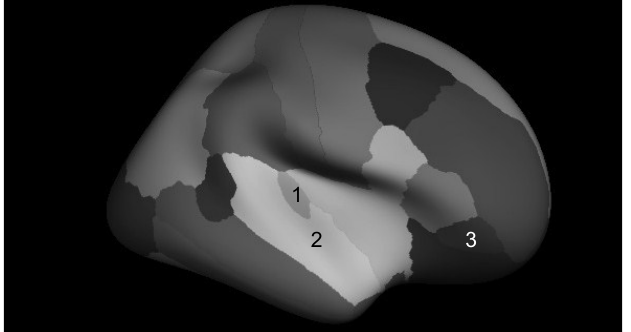
Figure 1. Cortical parcellation of the target regions of interest. ( 1 ) Transverse temporal gyrus; ( 2 ) Superior temporal gyrus; ( 3 ) Pars